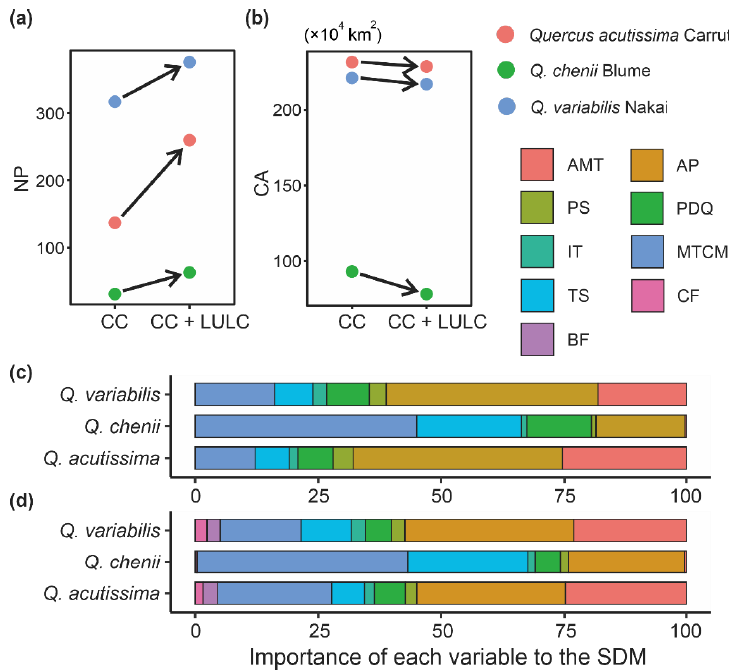
Figure 2. ( a , b ) Changes of landscape patterns, i.e., number of patches (NP) ( a ) and core area (CA) ( b ), between species distribution models (SDMs) only considering climate change (i.e., the CC model) and those considering CC as well as land use and land cover (LULC) change (i.e., the CC + LULC model). ( c , d ) Variable importance index provided by Maxent to evaluate the contributions of each variable to SDMs. ( c , d ) show the importance of each variable in the CC model and CC + LULC model, respectively. AMT, annual mean temperature; AP, annual precipitation; BF, broad-leaved forest; CF, coniferous forest; IT, isothermality; MTCM, minimum temperature of coldest month; PDQ, precipitation of driest quarter; PS, precipitation seasonality; TS, temperature seasonality.